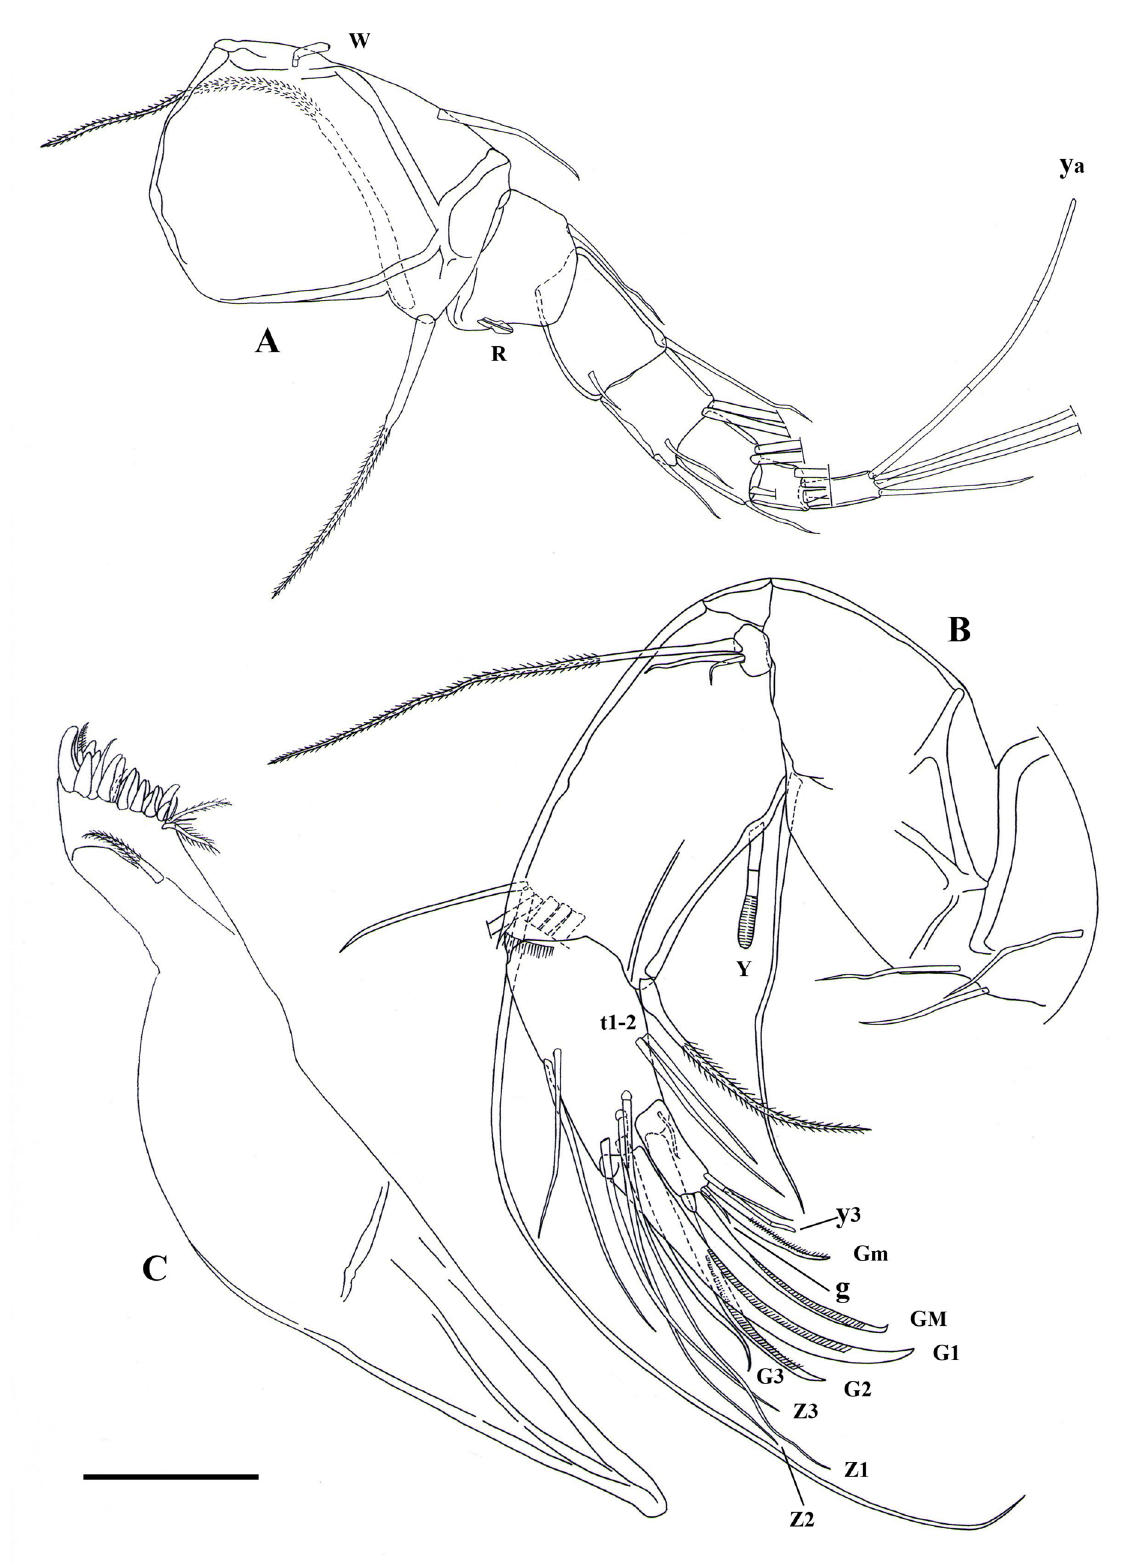
Fig. 2. Siamopsis renateae gen. et sp. nov., ♀ (MSU-ZOC.190). A . A1. B . A2. C . Md coxa. Scale bar: 50